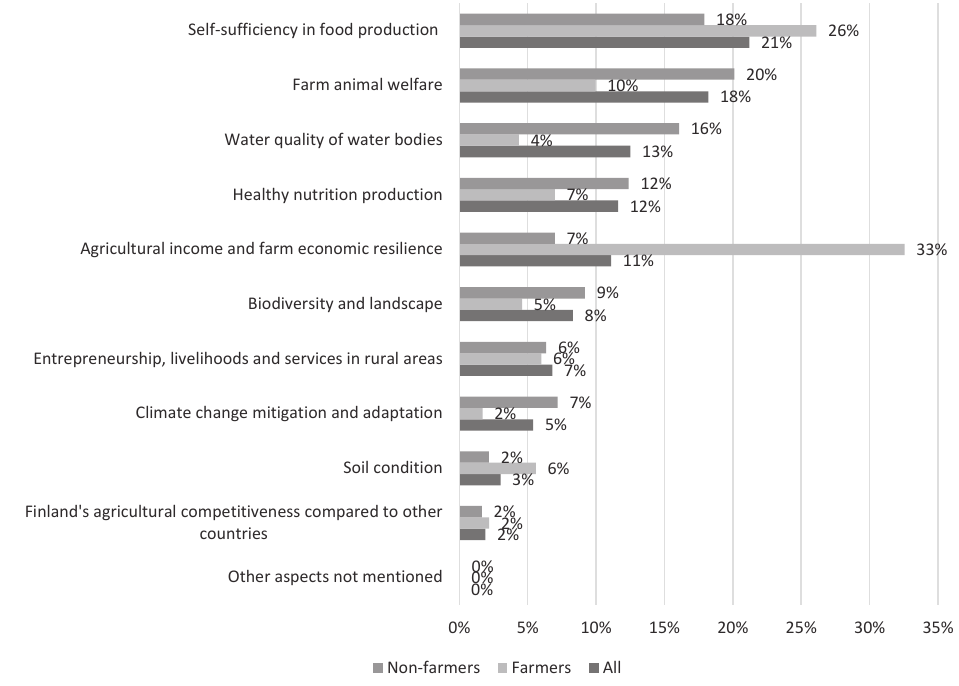
Fig. 1. The compositional means of the budget allocation